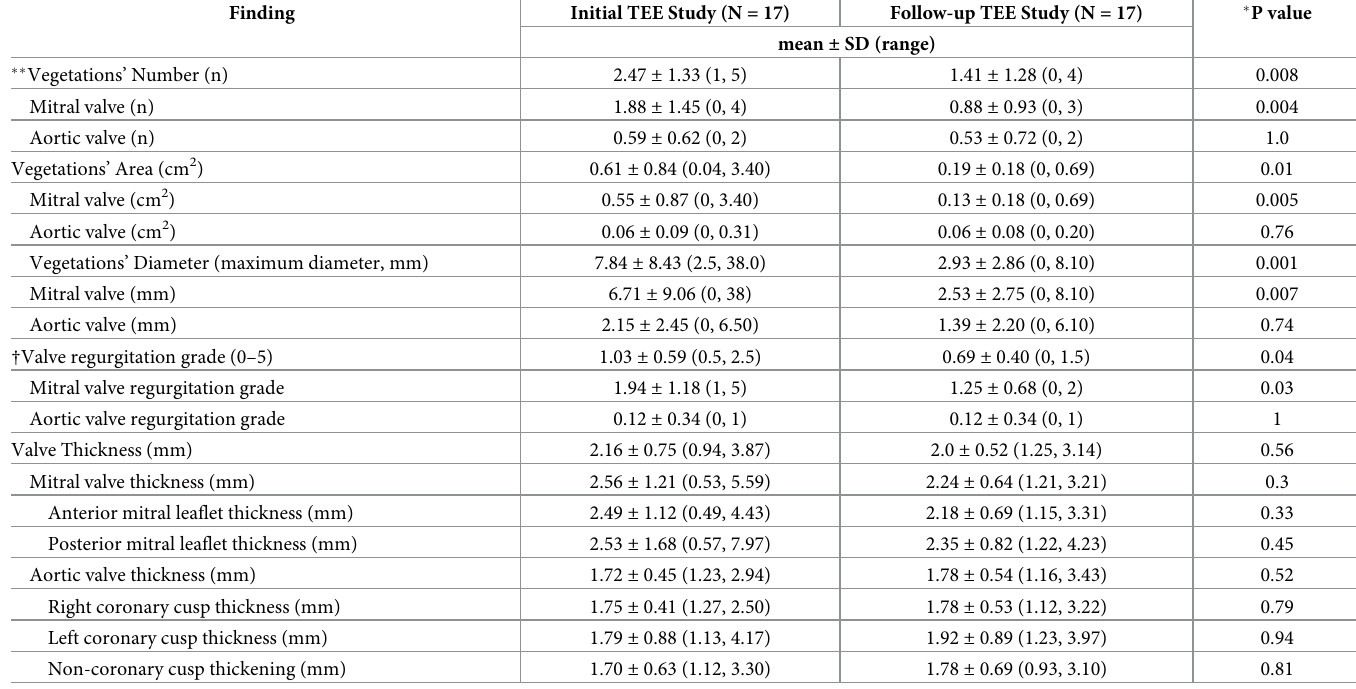
Table 3. Effect of medical therapy in patients with Libman-Sacks endocarditis.